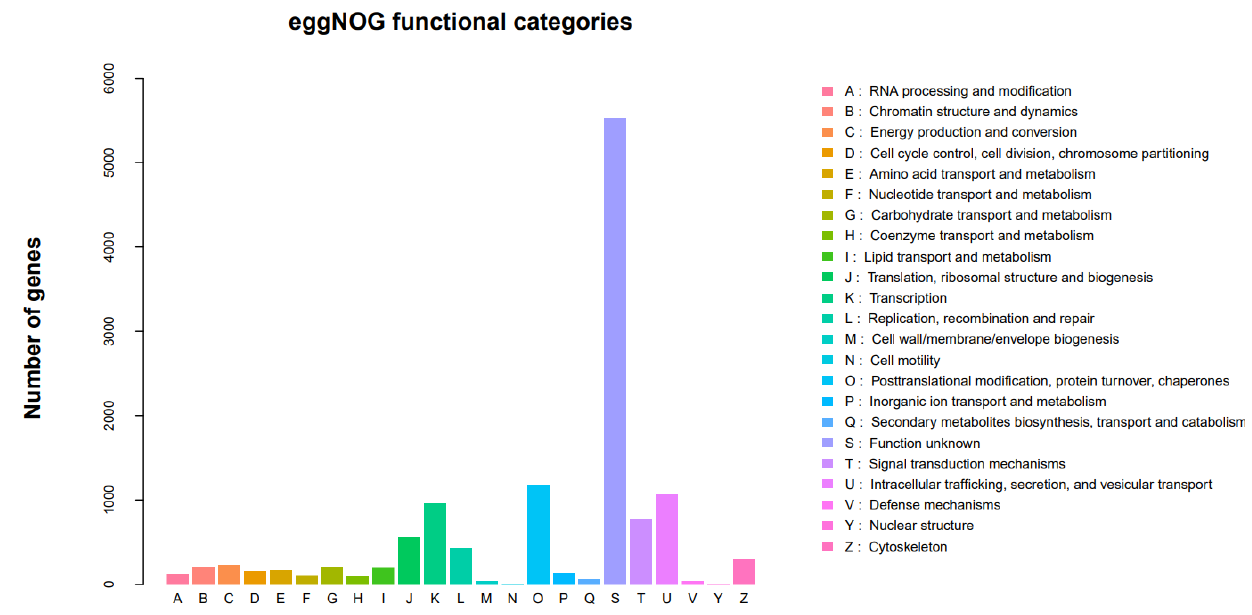
Figure 5. Histogram presentation of EggNOG classification.